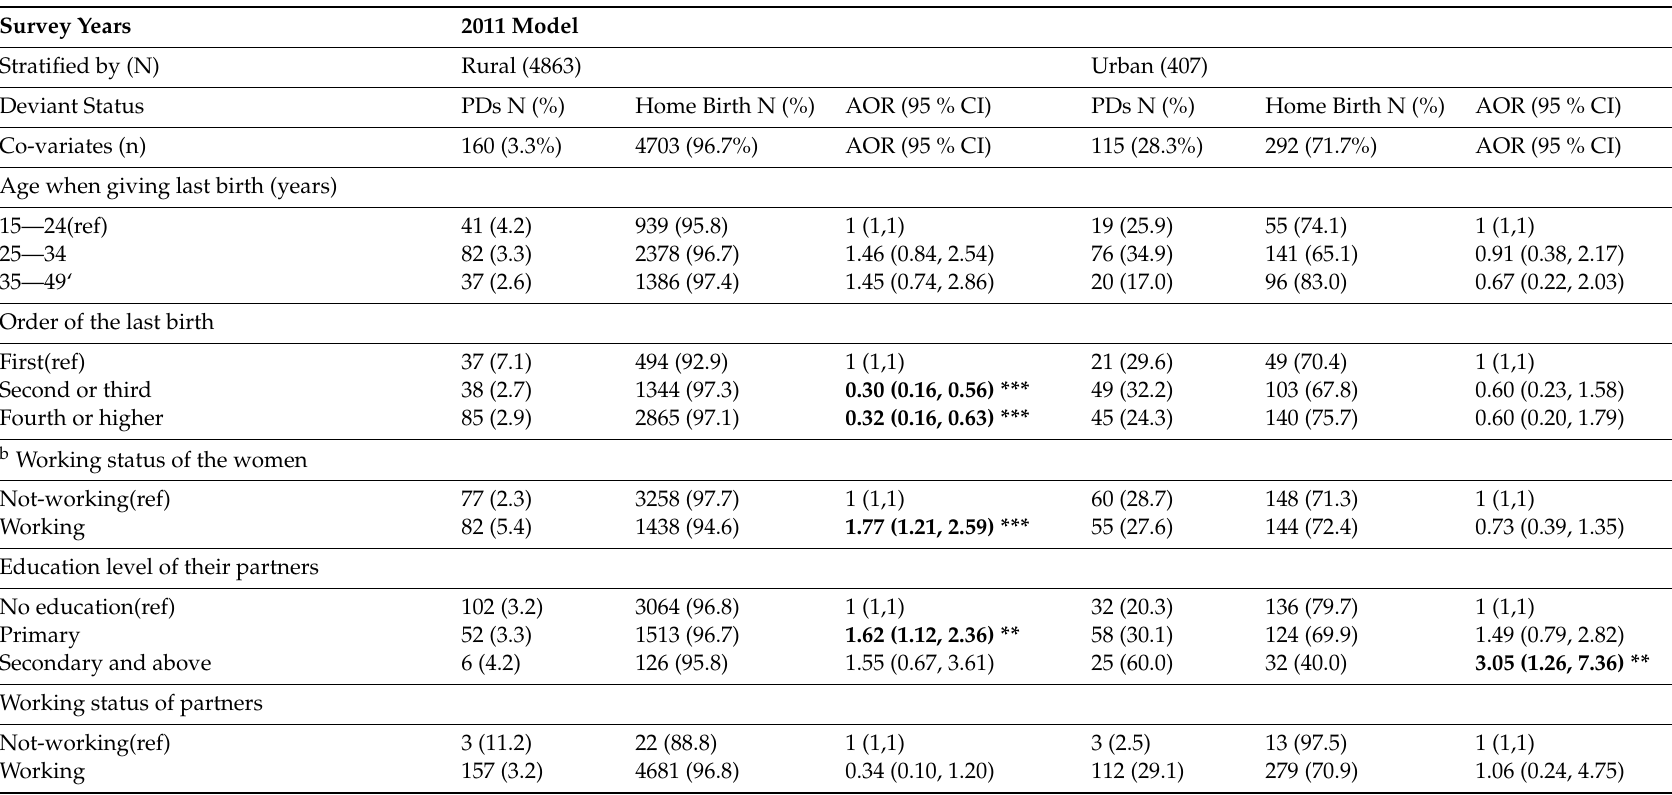
Table 4. Results of multiple multilevel logistic regression exploring factors associated with being a positive deviant for having a health facility delivery among urban and rural women, 2011 Ethiopia